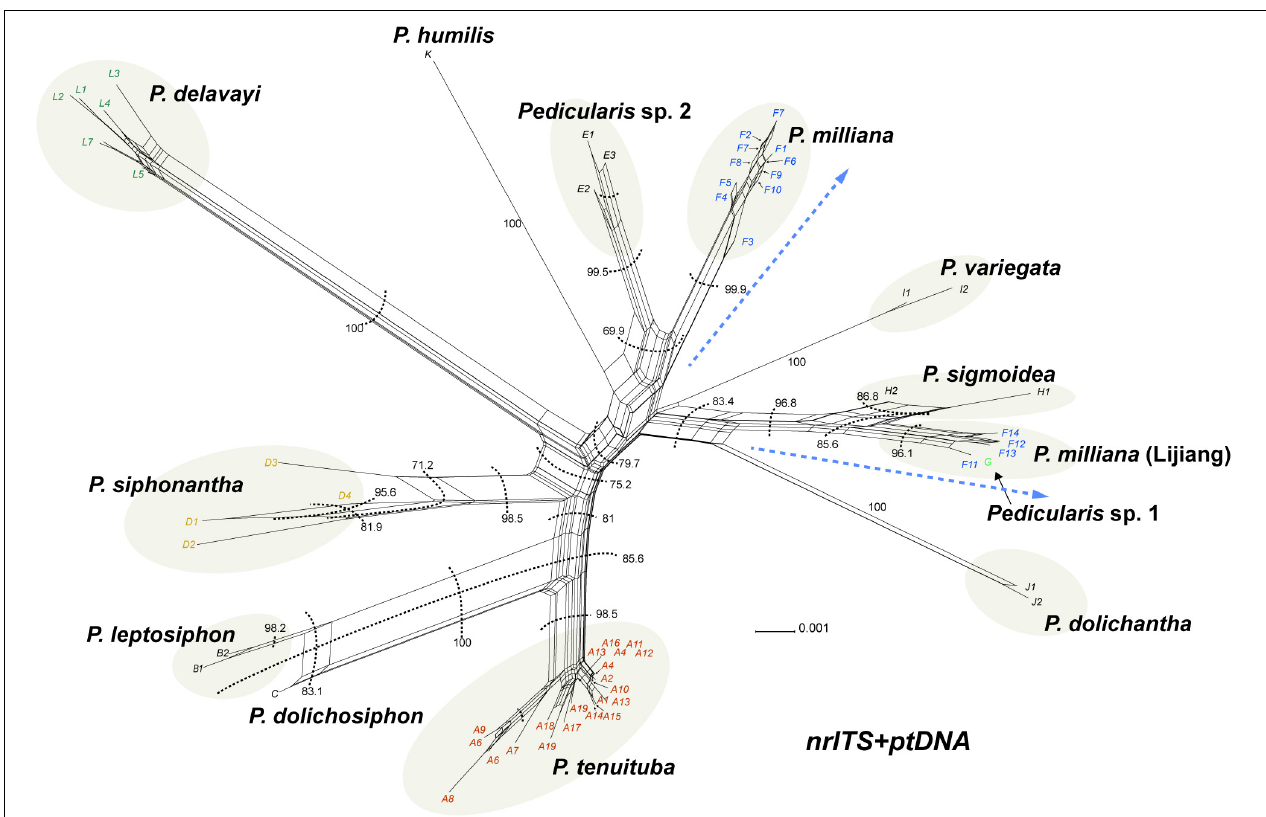
FIGURE 6 | Neighbor-net analysis of Pedicularis siphonantha complex using complete nrITS + ptDNA datasets. Bootstrap support values for clusters are indicated next to the respective cluster delimitation (dashed lines); blue dashed lines indicate the split of Pedicularis